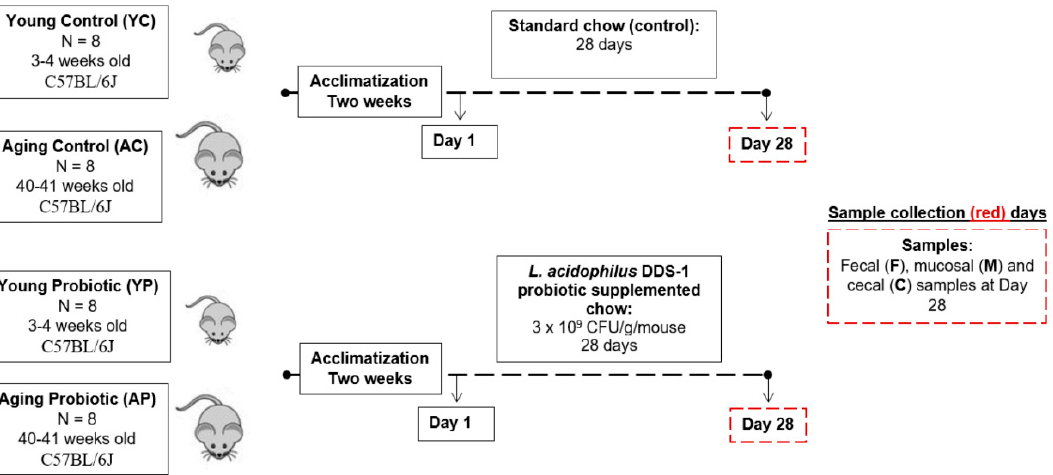
Figure 1. Experimental design to analyze the efficacy of L. acidophilus DDS-1 in young and aging C57BL/6J mice. The controls groups (YC and AC; n = 8 per group) were fed standard chow, and the treatment groups (YP and AP; n = 8 per group) were fed with chow supplemented with L. acidophilus DDS-1 daily for 28 days. (YC) Young control group, (YP) young probiotic group, (AC) aging control group, and (AP) aging probiotic group.